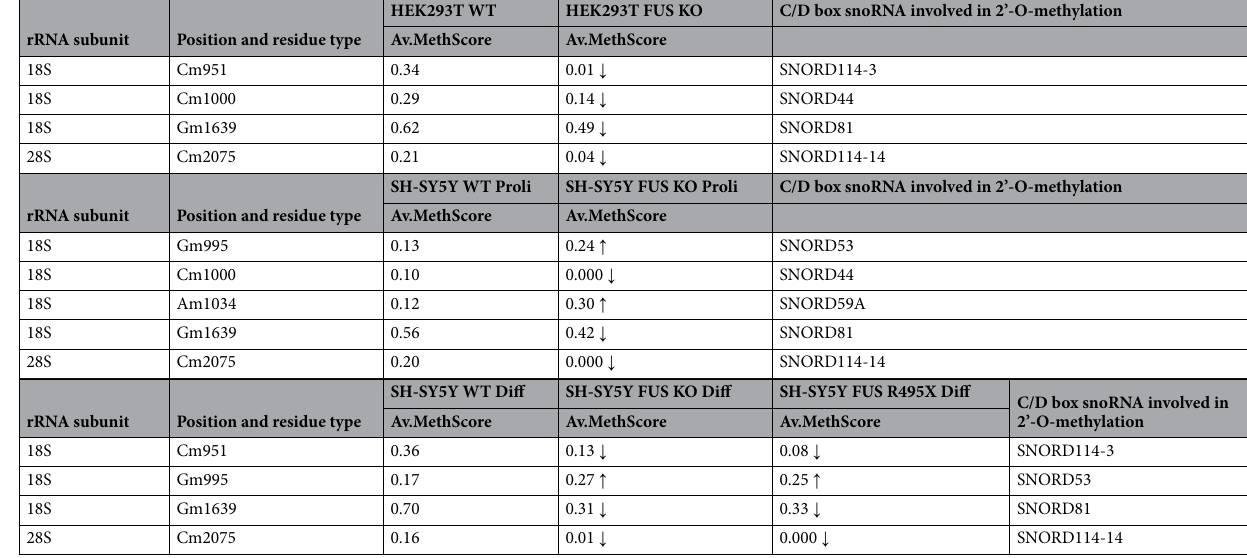
Table 4. Putative 2’-O-methylation positions in rRNAs as identified by Snoscan (v.1.0). The MethScores represent the average of three biological replicates and describe a fraction of molecules methylated at a given position. Arrows depict the direction of modification changes in FUS KO and FUS R495X cells relative to WT